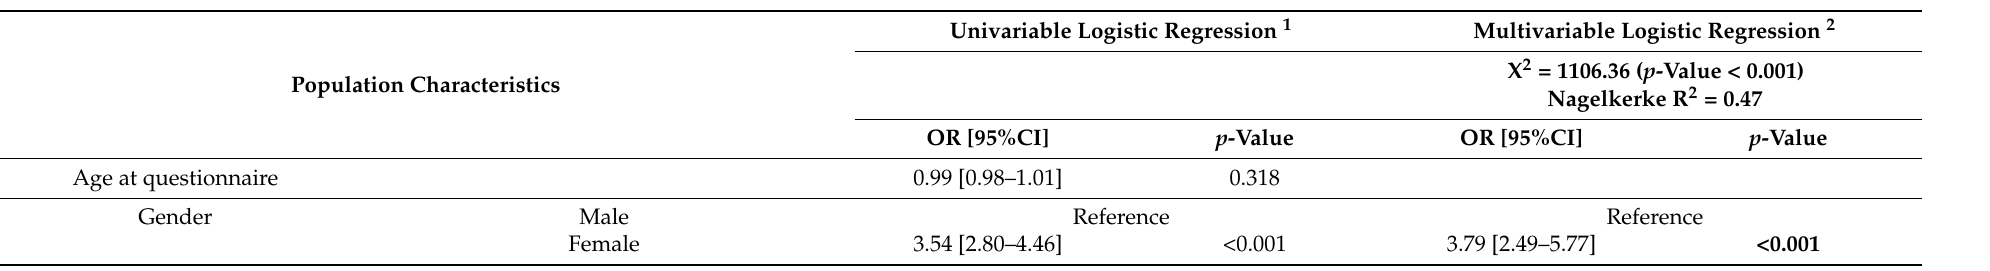
Table 4. Univariable and multivariable logistic